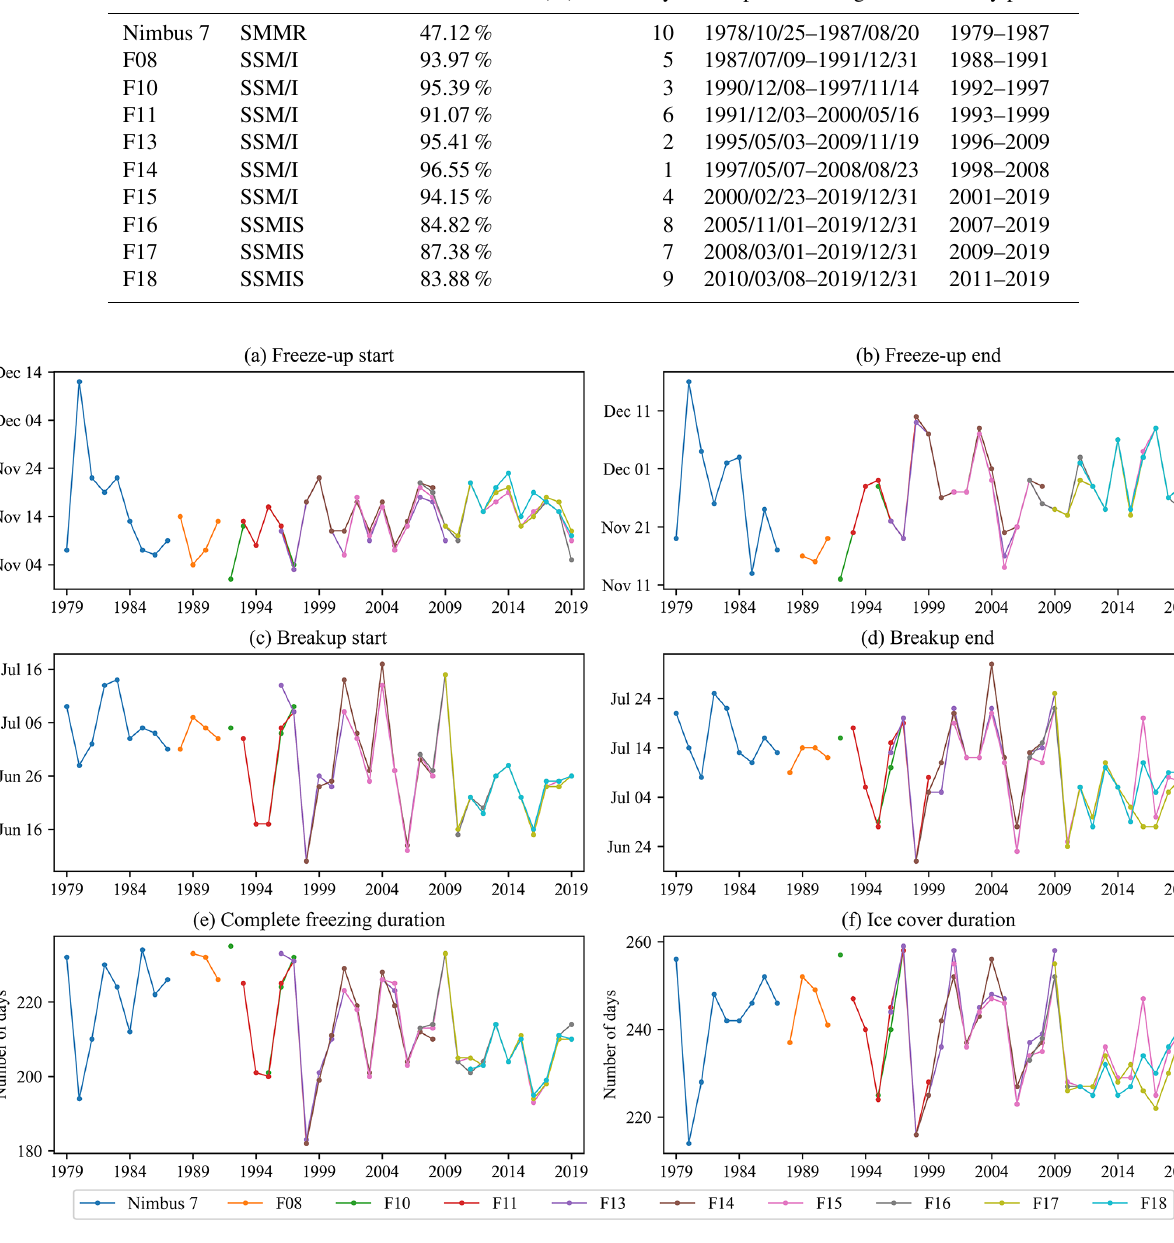
Figure 3. Lake ice phenology for Great Bear Lake extracted from multiple satellites, showing the (a) freeze-up start date, (b) freeze-up end date, (c) breakup start date, (d) breakup end date, (e) complete freezing duration, and (f) ice cover